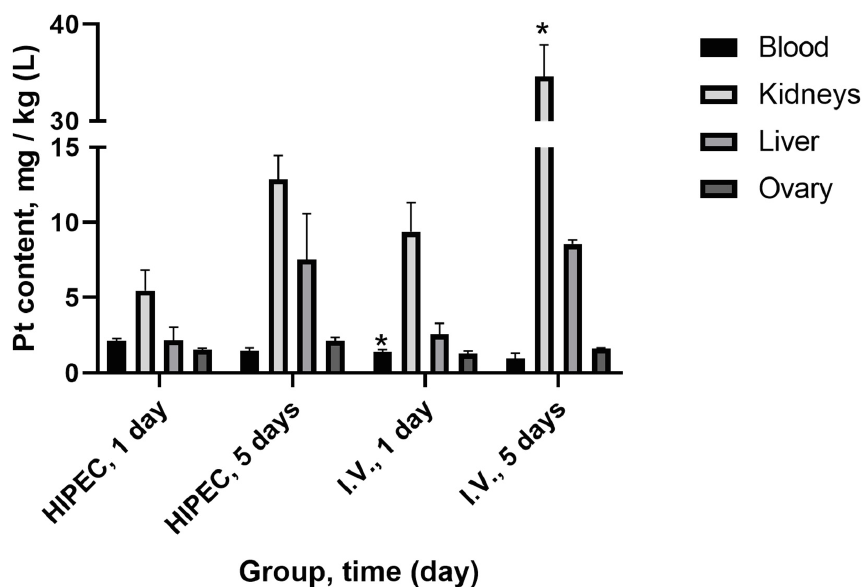
Figure 2. Platinum concentration in blood and organs (mean ± SEM) in rats after perfusion (HIPEC) with cisplatin (20 mg/kg b.w., n = 3) and intravenous (i.v.) injection (4 mg/kg b.w., n = 3) after 1 and 5 days. *— p < 0.05 compared to HIPEC (Mann–Whitney U rank test).